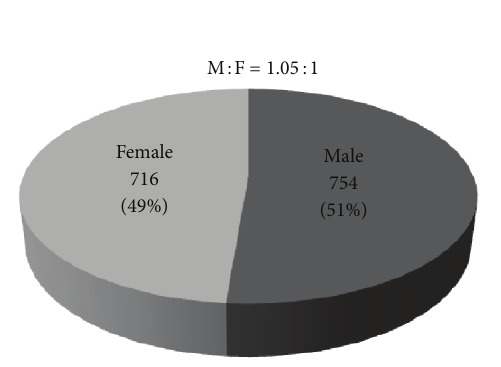
Figure 1: Distribution of